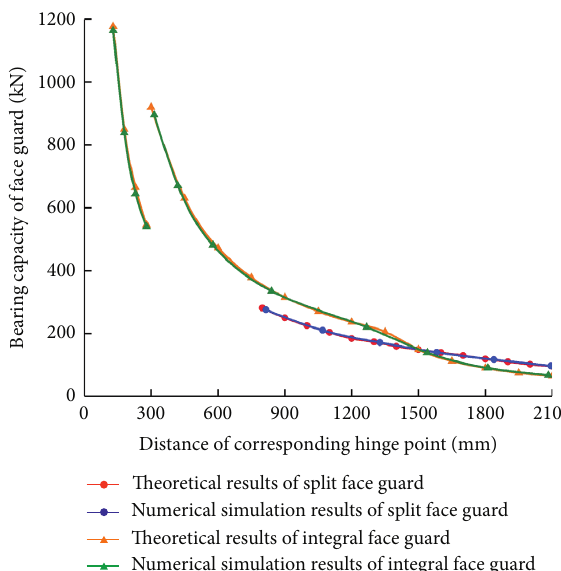
Figure 12: Comparative analysis of the bearing capacity of the two kinds of structural forms of face guard.